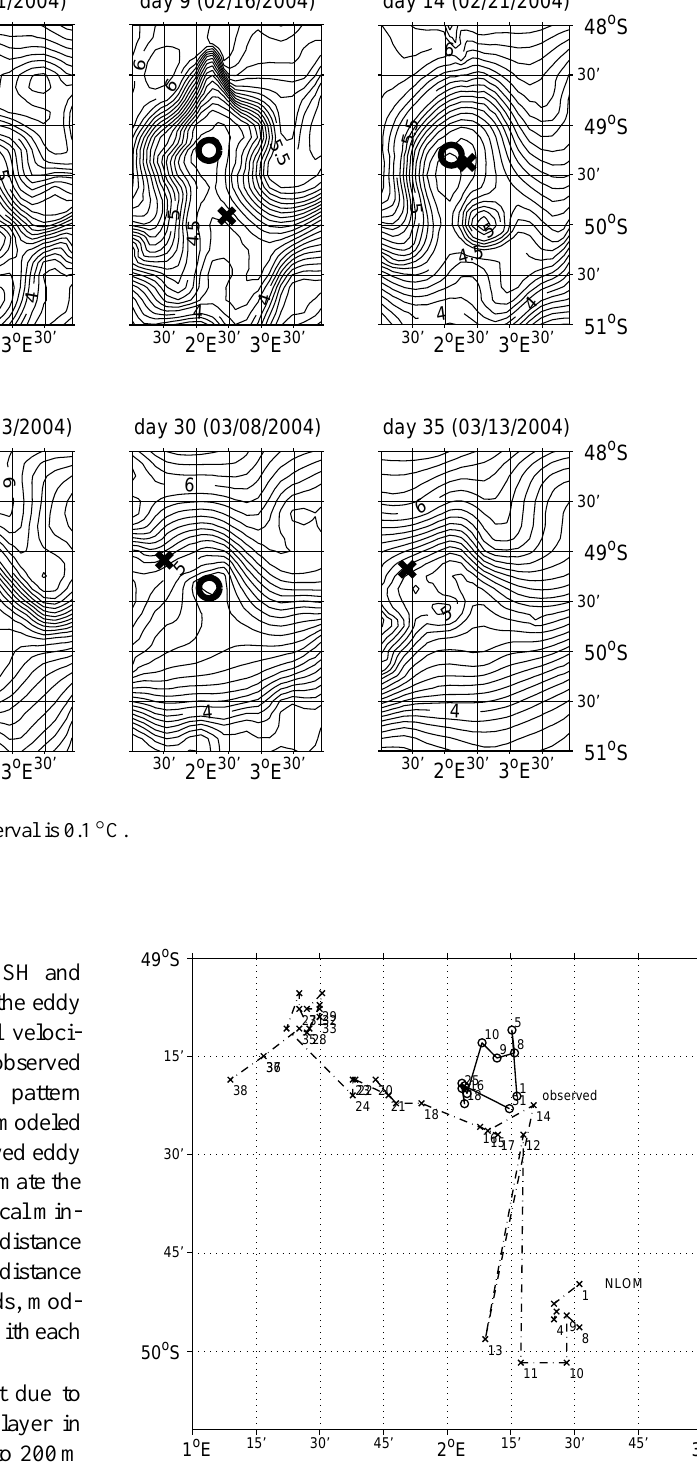
Fig. 3. Displacement of eddy center as estimated from direct veloc- ity observations (circles) and model data (crosses). The annotations refer to the experiment day. Day 1 is 8 February